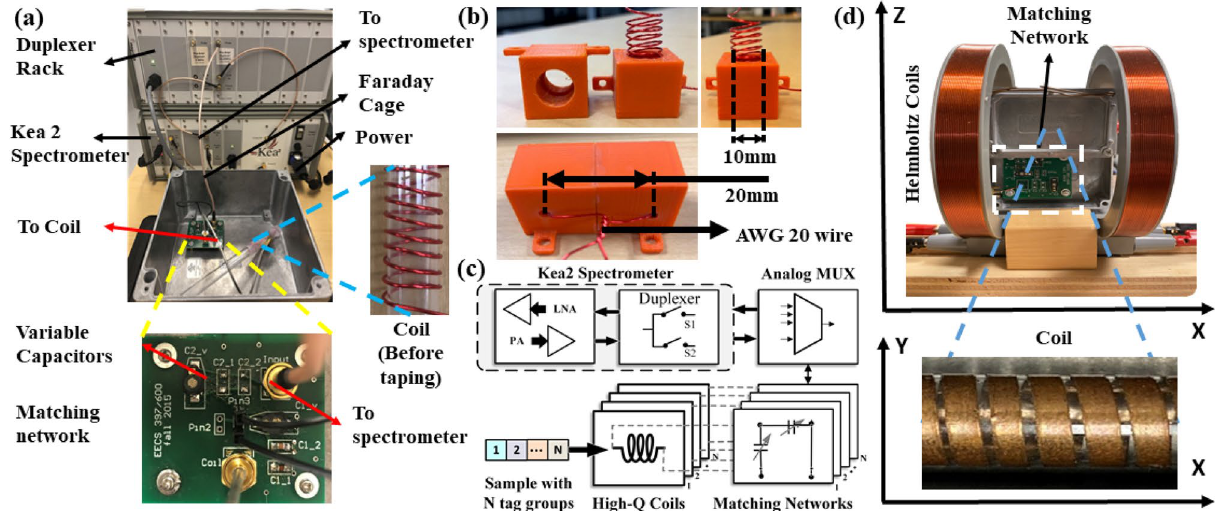
Figure 6. ( a ) The basic experimental setup, which consists of a bench-top MR spectrometer (Magritek Kea2), duplexer rack, impedance matching network, and solenoid coil. ( b ) A single spatially-selective detector 10 mm, length 20 mm, 13 turns) wound using AWG 20 copper wire. This particular version (diameter = = was designed to scan small objects (diameter < 10 mm) that fit within the detector. ( c ) Block diagram of the 4 spatially-selective analog front-end (AFE) used to read-out embedded NQR-active signatures. A total of N = detectors is shown. Here PA power amplifier (used to generate RF pulses) and LNA low-noise amplifier = = (used to amplify the resulting spin echoes). ( d ) Modified experimental setup used for relaxation-based imaging. A set of Helmholtz coils is used to generate the necessary static field gradient [Microsoft extrusion temperatures > 240 ◦ C should be avoided to prevent melting of the NaClO 3 crystals. Thus, the NaClO 3 40 µ m) before being used in filament is powdered using a grinder (resulting in a typical particle diameter ≈ extrusion. We also observed that the initial extrusion step does not distribute the tag evenly throughout the filament. Thus, the initially-extruded filament is broken into small parts and again fed into the extruder. The result of this second extrusion is a filament with a relatively uniform distribution of NaClO 3 that is suitable for printing embeddded signatures.